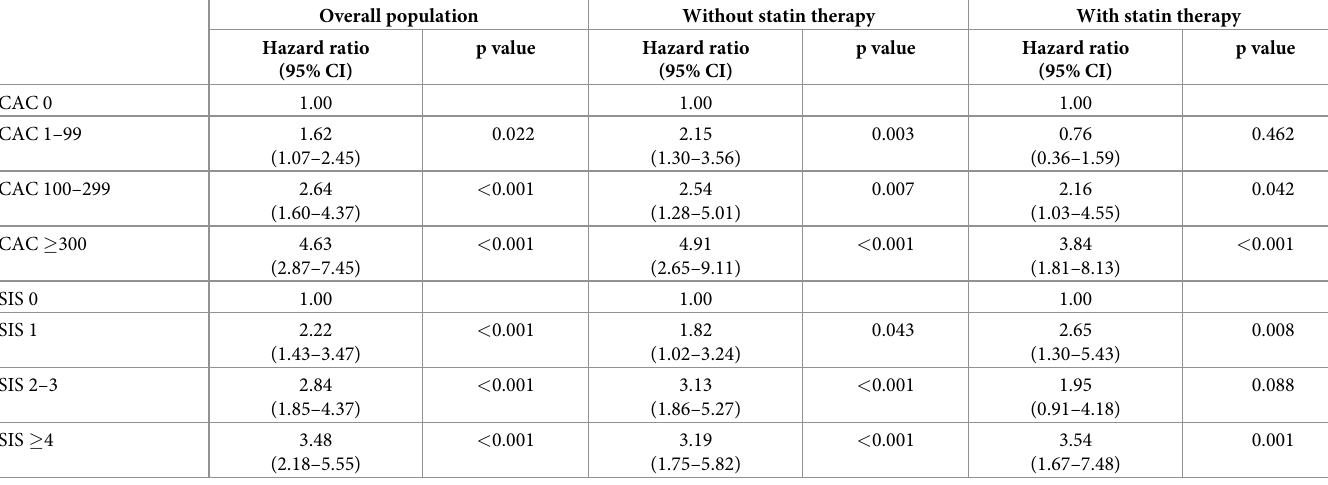
ated with higher risk of MACE (p < 0.05). Relative to those with SIS = 0 not taking baseline statins, the adjusted risk of MACE was significantly increased in patients with SIS � 1. How- ever, this association was abated in patients with statin therapy. Table 4. Adjusted association between major adverse cardiac events (MACE) a , CAC, SIS, and baseline statin therapy b . Overall population Without statin therapy With statin therapy Hazard ratio (95%